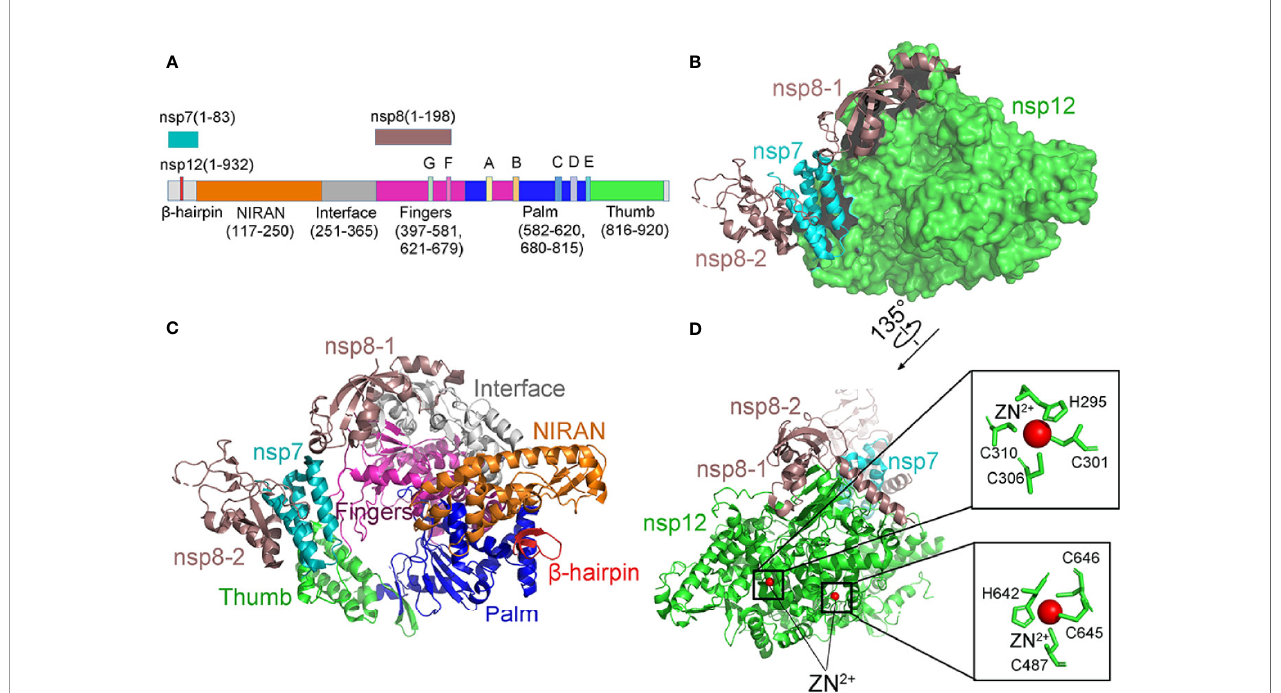
FIGURE 10 | The structure of the apo RdRp complex. (A) The schematic diagram for the components of the RdRp complex, which contains nsp7, nsp8, and nsp12. The polymerase motif (A-G) and b -hairpin are highlighted because it is unique to the SARS-CoV-2. (B, C) Two views structure of the apo nsp12-nsp7-nsp8 complex. nsp12 consists of an N-terminal b -hairpin (residues 31 – 50) and an extended nidovirus RdRp-associated nucleotidyl-transferase domain (NiRAN, residues 115 – 250). An interface domain (residues 251 – 365) is following the NiRAN domain. The nsp12 RdRp domain shows the canonical cupped right-handed con fi guration with the fi nger subdomain. NiRAN, Interface, Fingers, Thumb, Palm, nsp7, nsp8 are shown in orange, gray, hot pink, green, blue, cyan, and violet, respectively. (D) The conserved zinc-binding motifs in the apo structure rendered in ribbon are highlighted. The residues are shown as green sticks, and zinc is shown as red spheres. All structures are drawn by